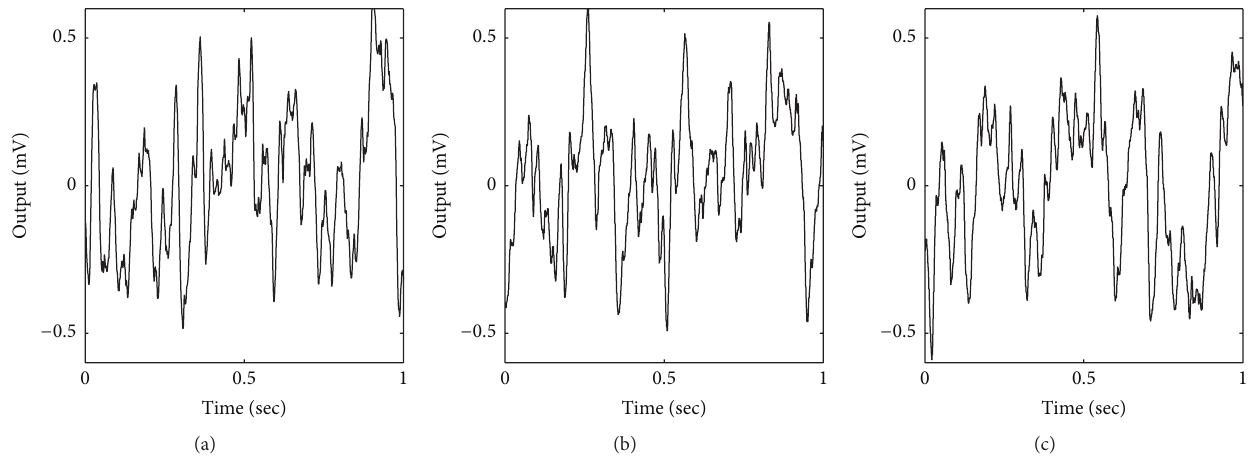
Figure 4: Examples of using forward Euler for SDEs. (a) For integration step size of 1 ms, the variance (𝜎 2 ) of the output is 0.0779. (b) For integration step size of 0.1ms, 𝜎 2 is 0.0655. (c) For integration step size of 0.01 ms, 𝜎 2 is 0.0621. Variances were computed using 10 seconds of output. Model parameters: 𝐴 = 5 , 𝐵 = 40 , and 𝐺 = 20 .